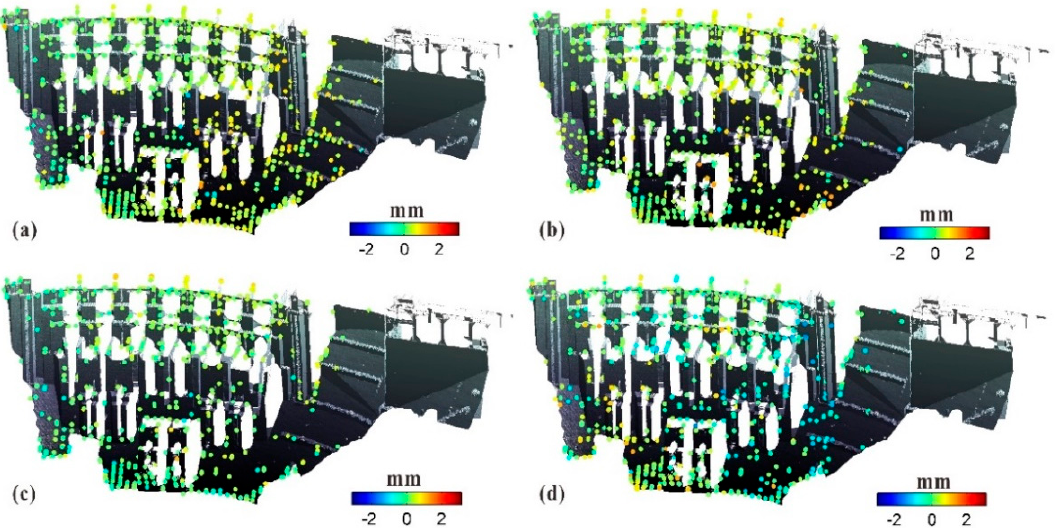
Figure 11. Mapping of cumulative deformation of dam surface to 3D dam model for four time periods: